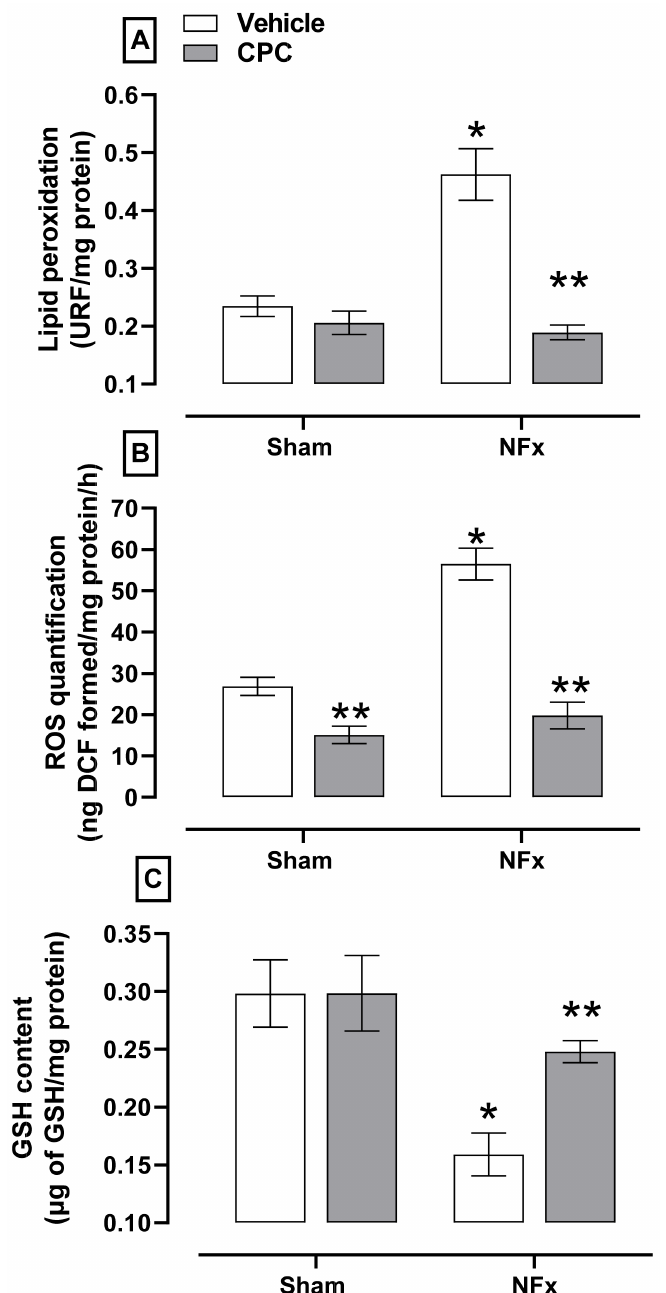
Figure 4. Effect of C-phycocyanin on oxidative stress markers. ( A ) Lipid peroxidation, ( B ) ROS and ( C ) GSH as redox environment marker in the aorta of NFx rats. Values represent the mean ± SEM. (*) p < 0.05 compared to the sham + vehicle at the same concentration. (**) p < 0.05 compared to the NFx + vehicle. Two-way ANOVA and SNK post hoc